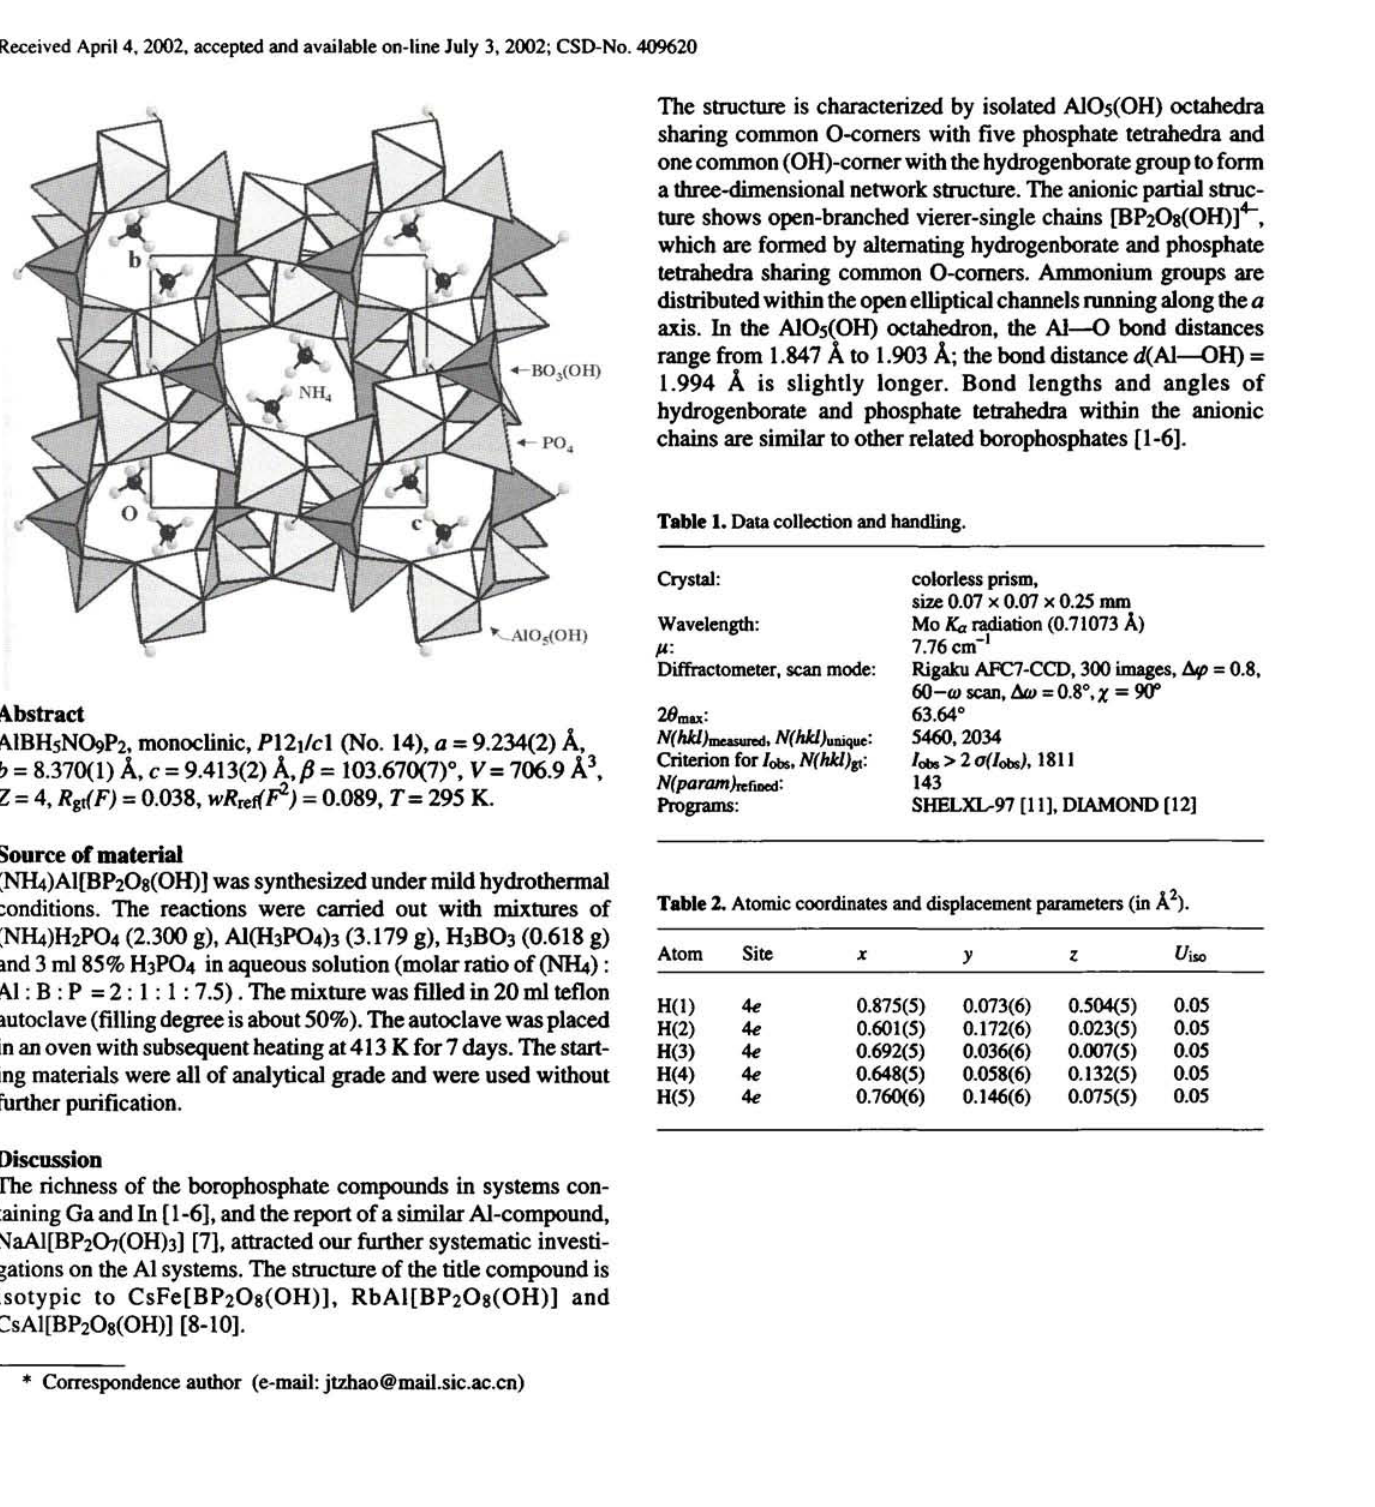
Table 2. Atomic coordinates and displacement parameters (in A 2